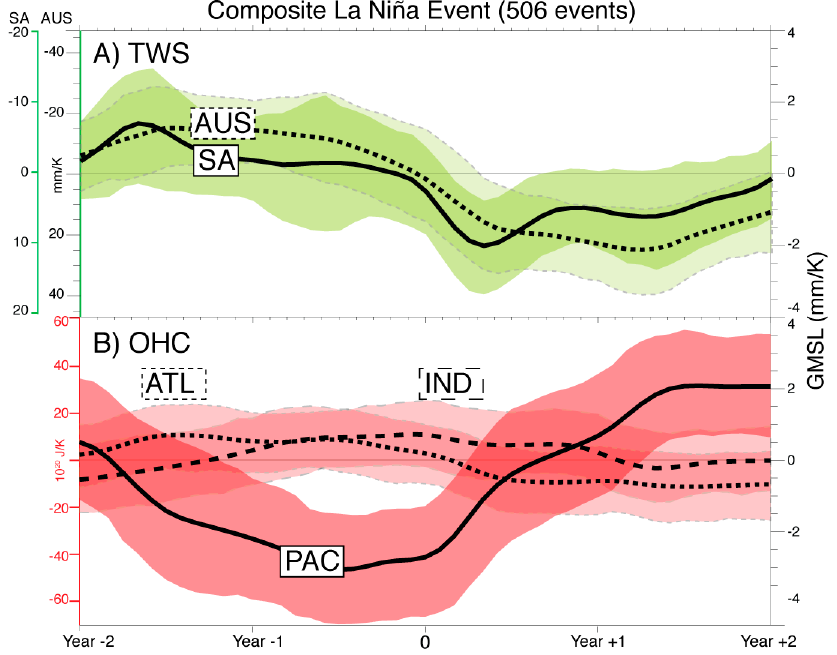
Figure 6. Contribution of key: ( A ) continental (TWS); and ( B ) ocean basin (OHC) contributions to the GMSL budget during La Niña. Shading indicates the σ range across ensemble members.